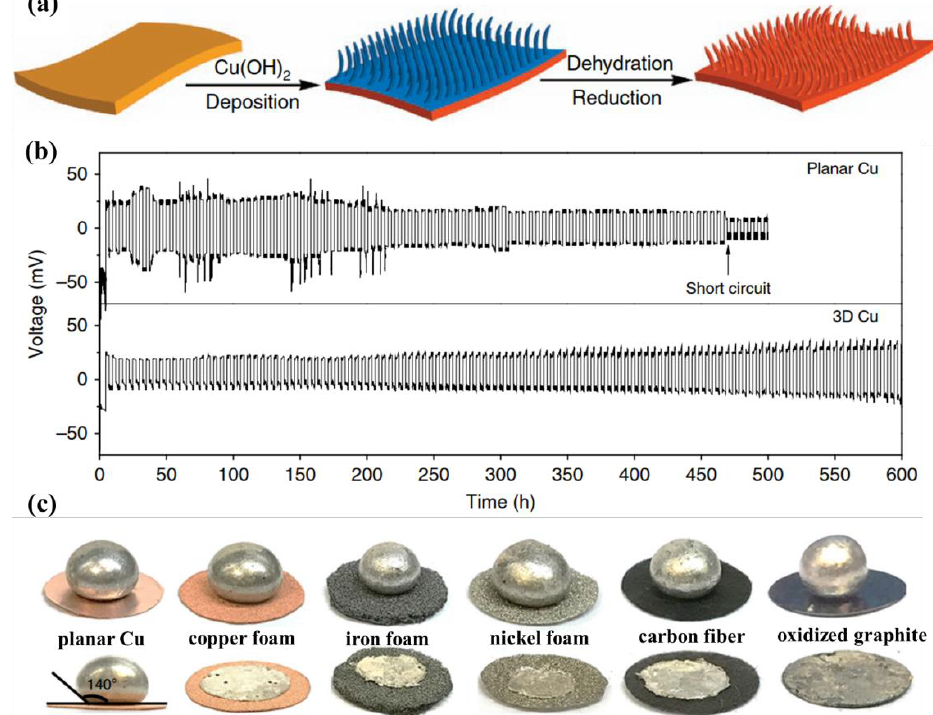
Figure 2. ( a ) Schematic presentation of the procedures to prepare a 3D porous Cu foil from a planar Cu foil. ( b ) Li metal plating/stripping at 0.2 mA cm −2 in symmetric Li|Li@Cu cells with planar or 3D Cu foil as a current collector [34] . Copyrights @ 2015 Macmillan Publishers Limited. All rights re- served. ( c ) Wettability of molten Li onto various substrates [23] . Copyrights @ 2019 Macmillan Pub- lishers Limited. All rights reserved.